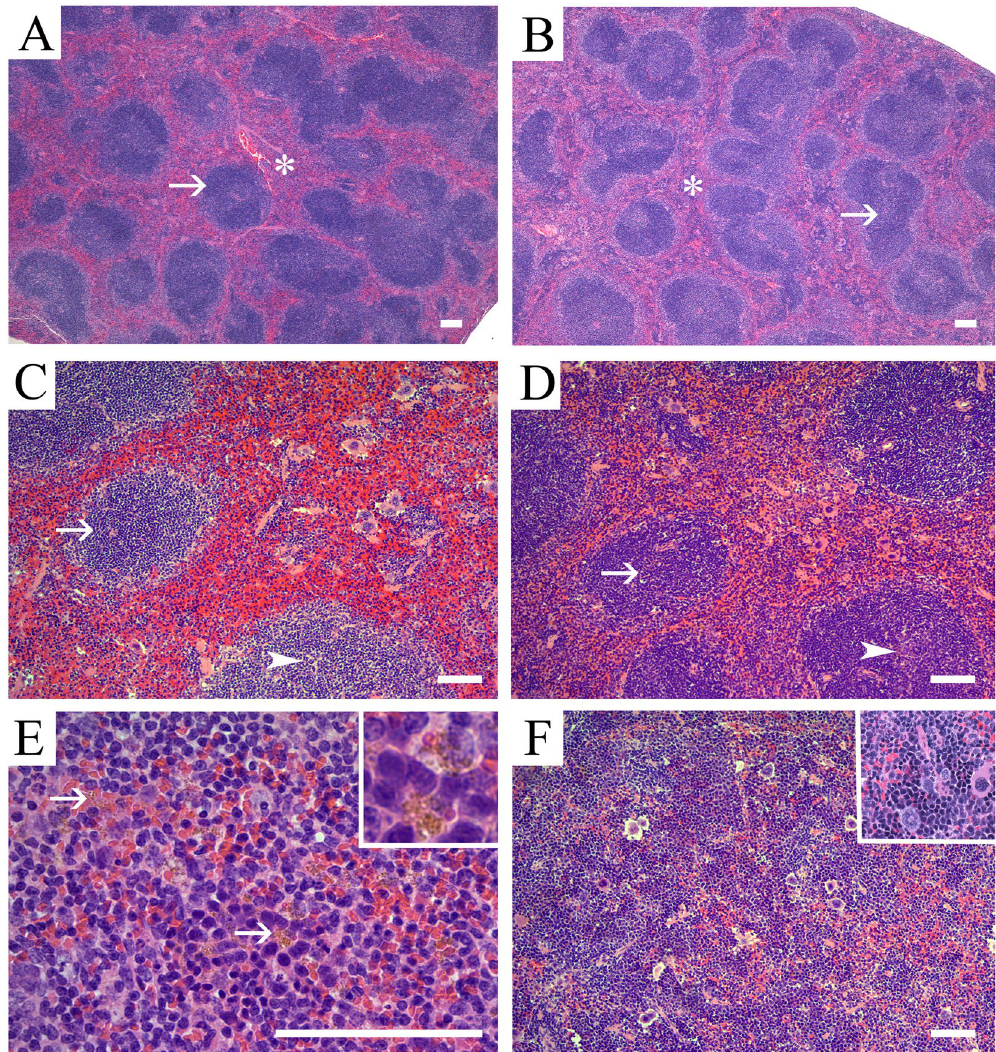
Figure 2. Representative photomicrographs of the splenic microanatomical structures in control and 17 α -ethinyl estradiol exposed adult male and female CD-1 mice. Shown are representative H&E stained sections of splenic tissue from ( A ) control male and ( B ) control female mice illustrating the normal micro- architecture of the white pulp (arrow) and red pulp (asterisk). Note that control tissue displays abundant white pulp components. ( C ) Representative images of males exposed to dietary 17 α -ethinyl estradiol (0.01 ppm EE). Decreased periarteriolar lymphoid sheath (PALS) numbers, size and cellularity (arrow), together with paucicellular primary lymphoid follicles (arrowhead) are evident. ( D ) Shown is an image for a representative female from the 0.01 ppm EE exposure group showing decreased PALS numbers and cellularity (arrow) with discrete primary lymphoid follicles and mildly decreased numbers of follicular lymphocytes (arrowhead). ( E ) Representative image of an EE-exposed male from the 0.01 ppm exposure group which demonstrates increased amounts of golden-yellow pigment (hemosiderin) in the red pulp that was often contained within macrophages (arrows and inset). ( F ) Representative image from a 0.0001 ppm EE exposed female demonstrating the observed phenotype of diffuse expansion of the red pulp by extramedullary hematopoiesis (EMH). The EMH was characterized by the presence of myeloid, megakaryocytic precursors, and a morphological predominance of erythroid precursors (inset). Scale bars indicate 100 µ